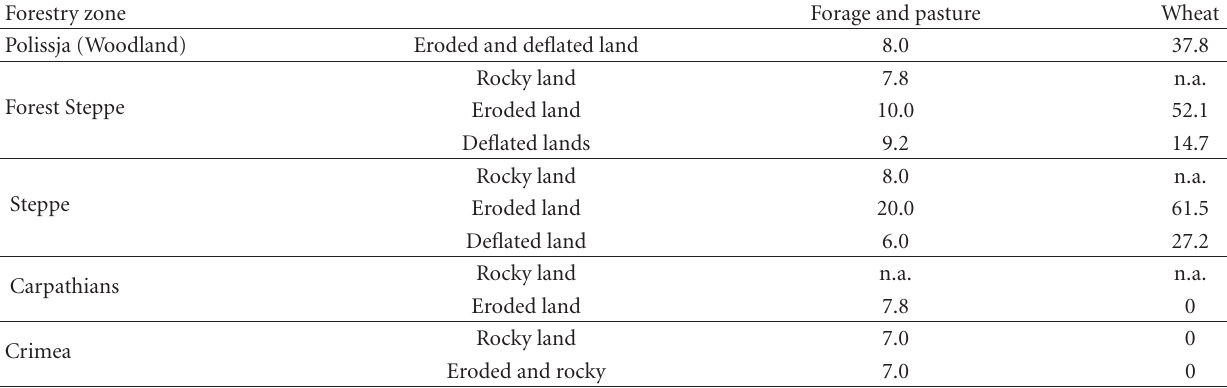
Table 2: Net annual returns to current agricultural activities,